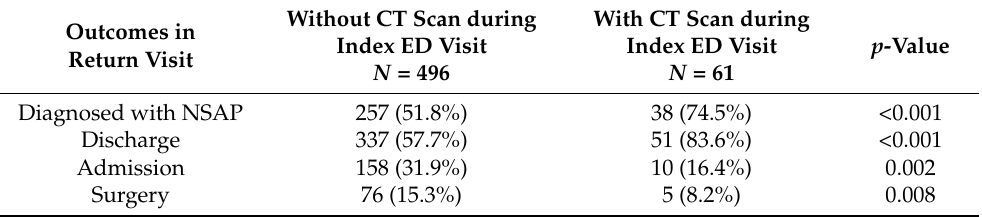
Table 4. Chi-square analysis of clinical outcomes after return ED visit in NSAP patients with or without a CT scan in their index